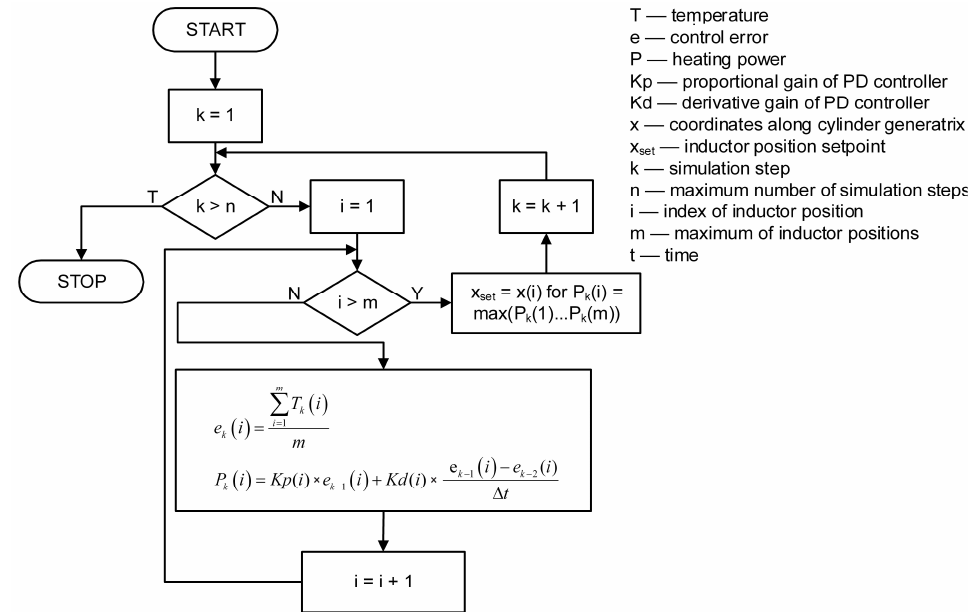
Figure 15. Inductor movement algorithm based on the temperature profile of the cylinder surface.